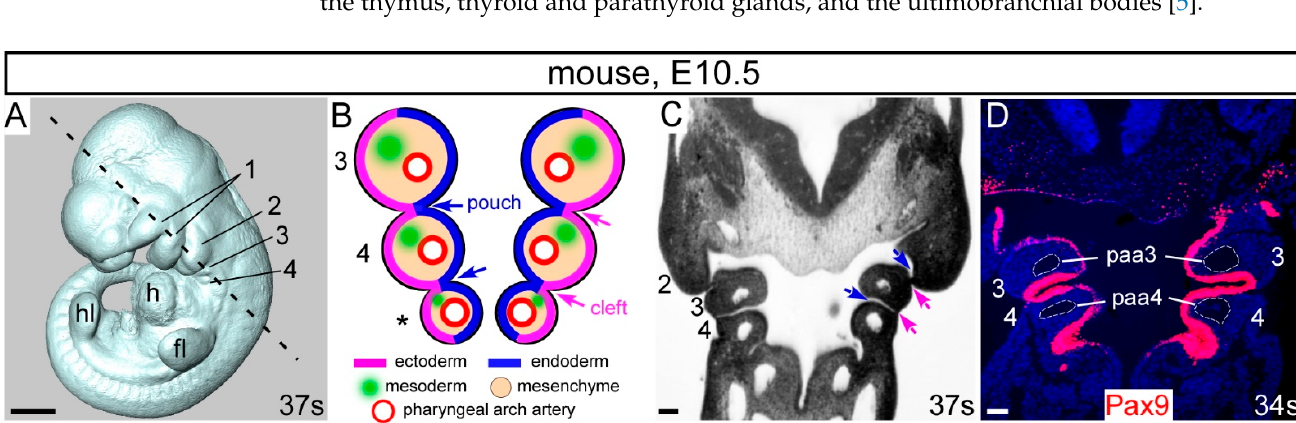
Figure 1. The pharyngeal arches. ( A ) Mouse embryo at E10.5 with 37 somites (s) with the pharyngeal arches 1–4 labelled. ( B ) Schematic coronal overview of the tissues and structures of the 3rd, 4th and ultimate (*) pharyngeal arches. Pharyngeal arches are numbered, and pharyngeal pouches (blue arrows) and pharyngeal clefts (pink arrows) indicated. Each pharyngeal arch is filled with neural crest-derived mesenchyme. ( C ) Coronal section of the embryo in ( A ) with the section plane shown with a dotted line. ( D ) Coronal section of an E10.5 embryo immuno-stained with an anti-Pax9 antibody, specifically labelling the pharyngeal endoderm. The 3rd and 4th pharyngeal arch arteries are indicated. Abbreviations: ec, ectoderm; en, endoderm; fl, forelimb bud h, heart; hl, hindlimb bud; paa, pharyngeal arch artery. Scale bar: 500 µ m in ( A ), 100 µ m in ( C , D